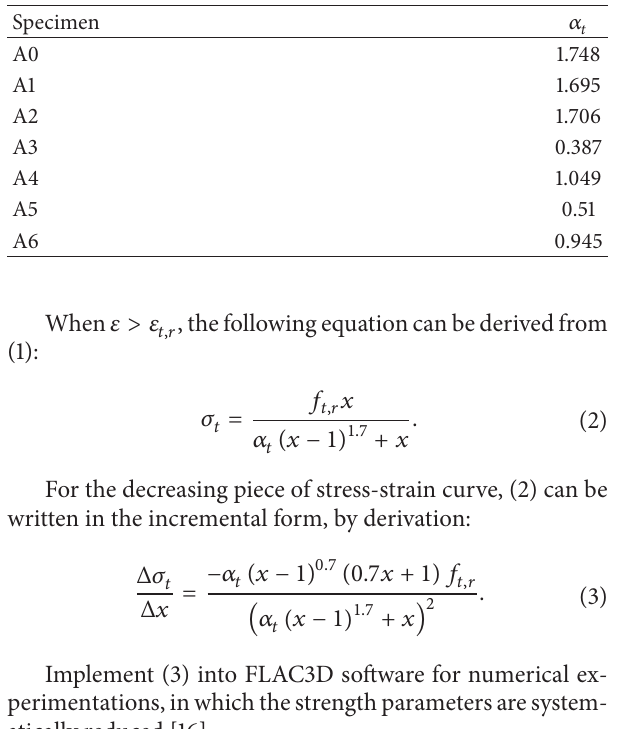
Table 4: Values of control parameter 𝛼 𝑡 for different specimens.